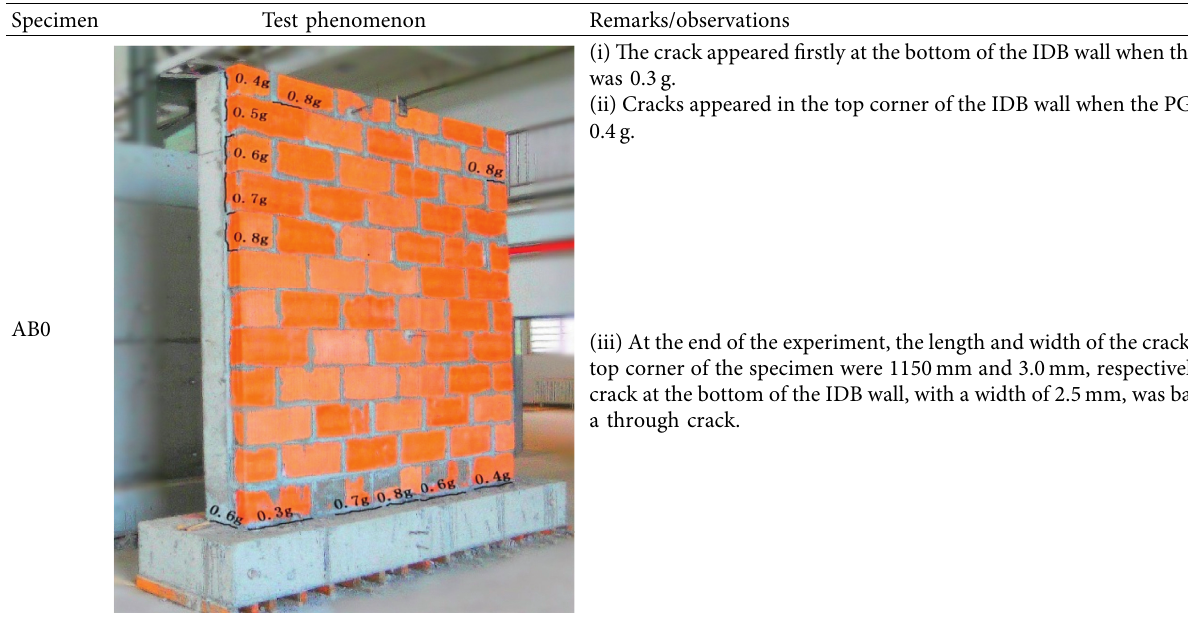
Table 5: Test observations and failure